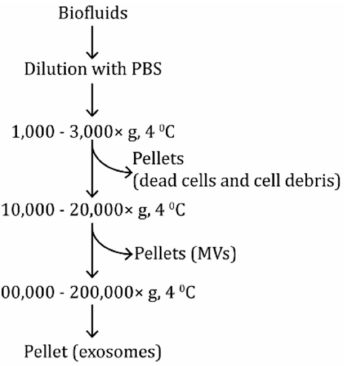
Figure 3. A basic di ff erential ultracentrifugation (dUC) workflow for isolation of MVs and